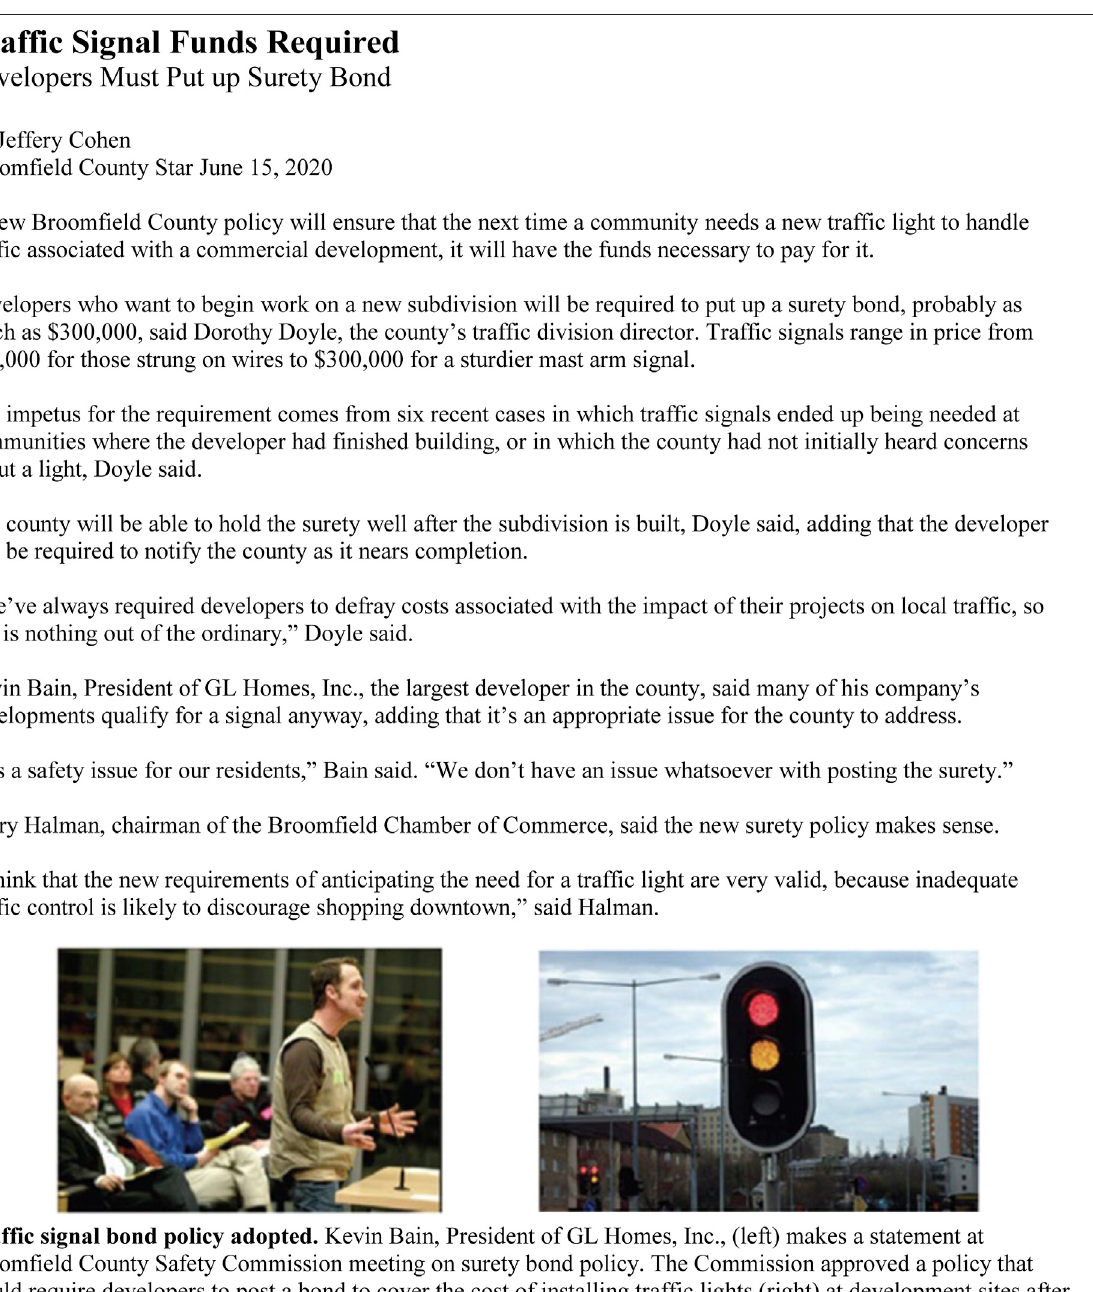
Frontiers in Communication |